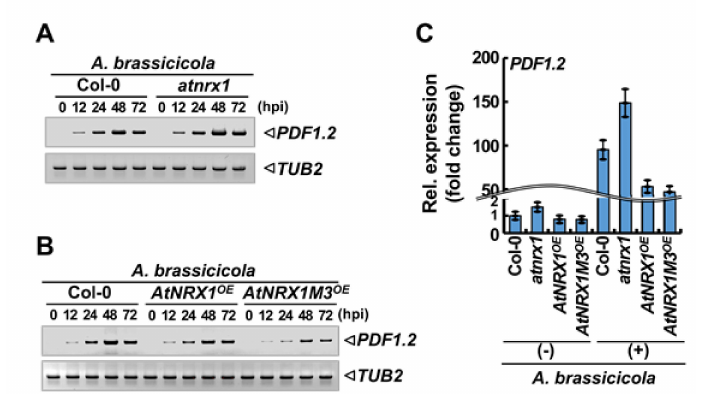
Figure 6. AtNRX1 negatively regulates JA-mediated PDF1.2 expression in Arabidopsis . ( A , B ) Semi- quantitative reverse transcription PCR (sqRT-PCR) analysis of PDF1.2 expression in Col-0 and atnrx1 ( A ) or Col-0, AtNRX1 OE , and AtNRX1M3 OE ( B ) plants infected with A. brassicicola . Mature leaves of 4-week-old Arabidopsis plants were inoculated with 3 µ L droplets of A. brassicicola spore suspension (10 6 spores / mL). Total RNA was isolated at the indicated time-points, and expression of PDF1.2 and TUB2 (control) was analyzed by sqRT-PCR. ( C ) Relative expression of PDF1.2 in Col-0, atnrx1 , AtNRX1 OE , and AtNRX1M3 OE plants before ( − ) or after ( + ) A. brassicicola infection. Droplets (3 µ L) of the spore suspension (10 6 spores / mL) were applied to mature leaves. Total RNA was isolated from the leaves, and expression of PDF1.2 relative to that of ACT2 , UBQ1 , and UBQ10 was determined by qRT-PCR at 48 h post-inoculation (hpi). Data represent mean ± SE ( n =